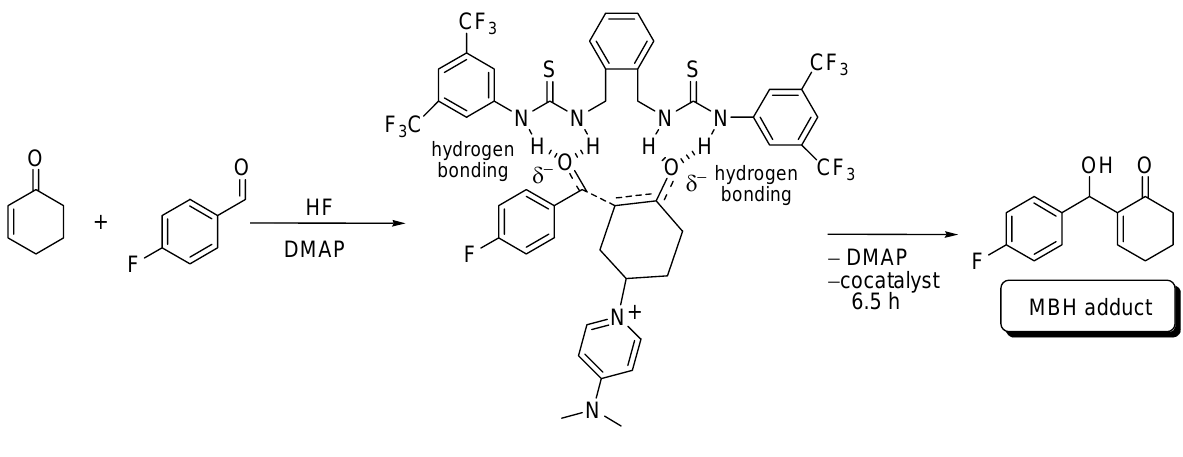
Figure 5. Aldehydes used in MBH reactions catalyzed by bis (thio)urea catalyst 16 .